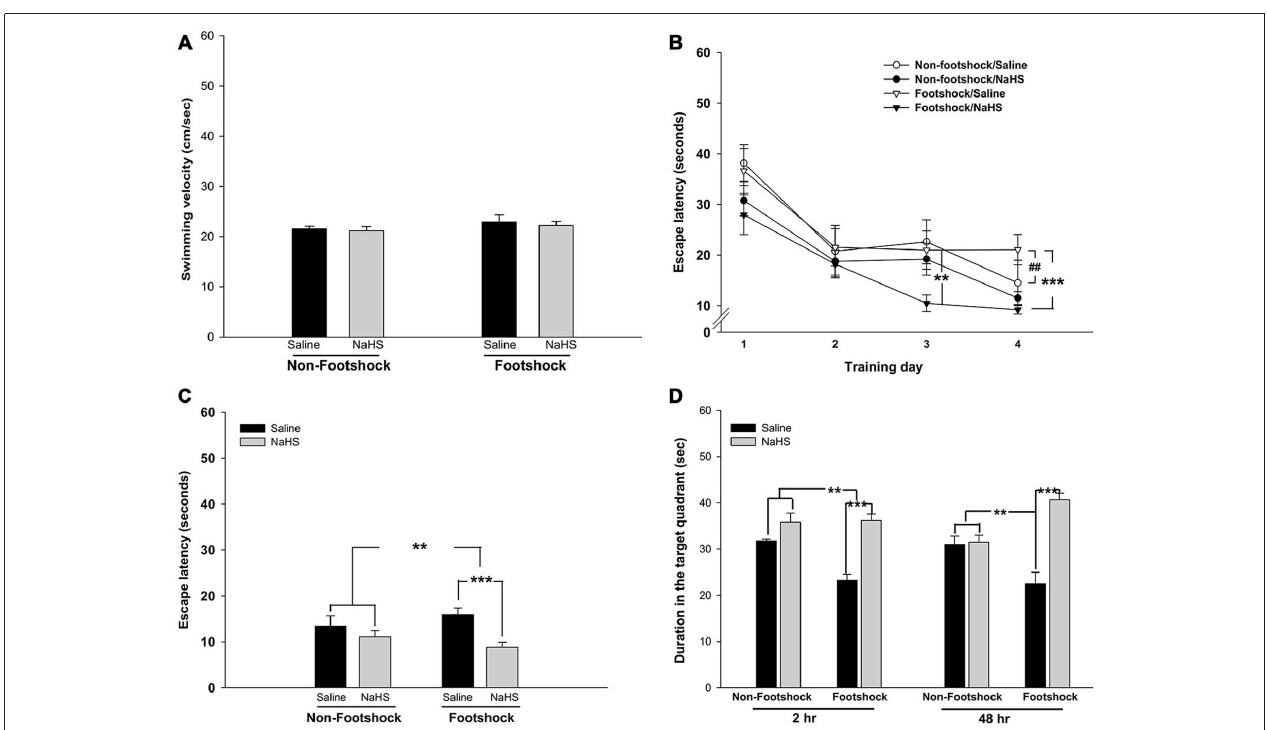
FIGURE 5 | NaHS treatment attenuated the impairment of cognition in footshock-stimulated 3 × Tg-AD mice. (A) Swimming velocity of the mice in the MWM. The mice in all groups had the same swimming ability. (B) Learning trends of the mice over the 4 training days of the MWM. Footshock accelerated the impairment of spatial learning ability and acquisition, and NaHS reduced the impairment in the footshock group. (C) The latency of mice to find the platform in the testing trials. The mice under footshock took longer to climb onto the platform than the control mice, and NaHS treatment ameliorated the impairment in the footshock group. (D) The results of short- and long-term memory retrieval. A probe trial was conducted 2 and 48 h after the last testing trial to evaluate short- and long-term memory retrieval. Footshock enhanced the impairment of short- and long-term memory retrieval, and NaHS attenuated the deficit. The data are the mean ± SEM of each group ( n = 15 per group). ∗∗ p < 0.01; ∗∗∗ p < 0.001. ## p < 0.01 for comparisons with the non-footshock/saline group.